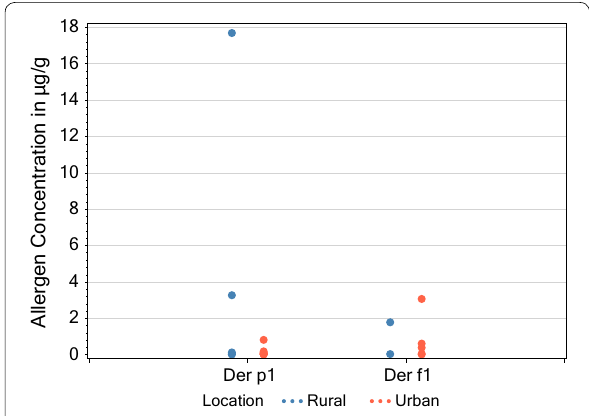
Fig. 2 Comparison of measurable (above the LoD) mite allergen dust concentrations in the lounges of rural and urban homes (respective rural and urban sample sizes (n) were 5 and 8 for Der p1 and 2 and 5 for Der f1). Statistical analysis (T-test unpaired 2 t-tailed) comparing rural and urban measurable values gave P-values of 0.157 and 0.779 for Der p 1 and Der f 1